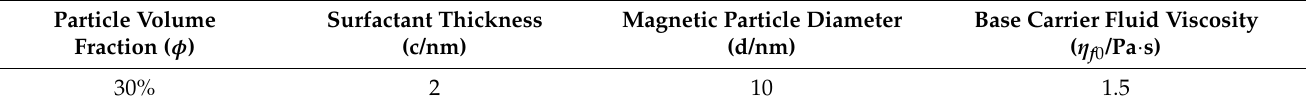
Figure 5. Magnetic fluid lubrication film viscosity – temperature and viscosity – pressure characteris- tics. Under the action of the applied magnetic field, the magnetic particles in the magnetic fluid are arranged into a chain structure with the same direction as the magnetic field strength by the magnetic moment, and its viscosity is greater than that of the absence of magnetic field strength. The modified equation for the viscosity of the magnetic fluid un- der the action of an applied magnetic field is: